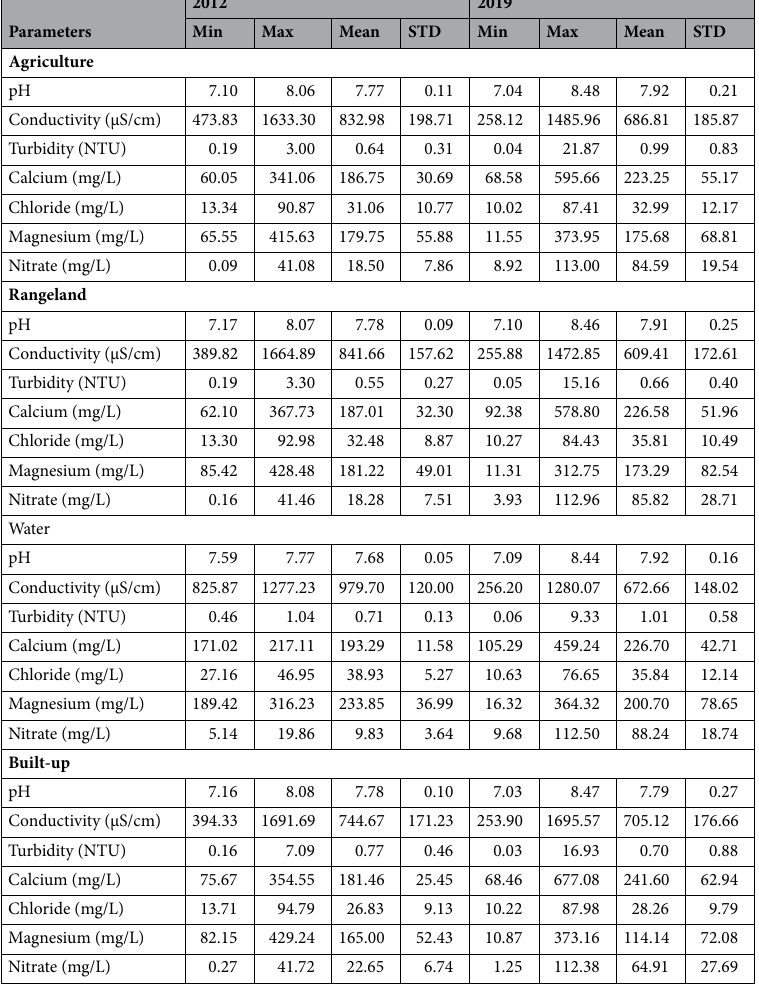
Table 5. The effect of land-use/landcover on water quality